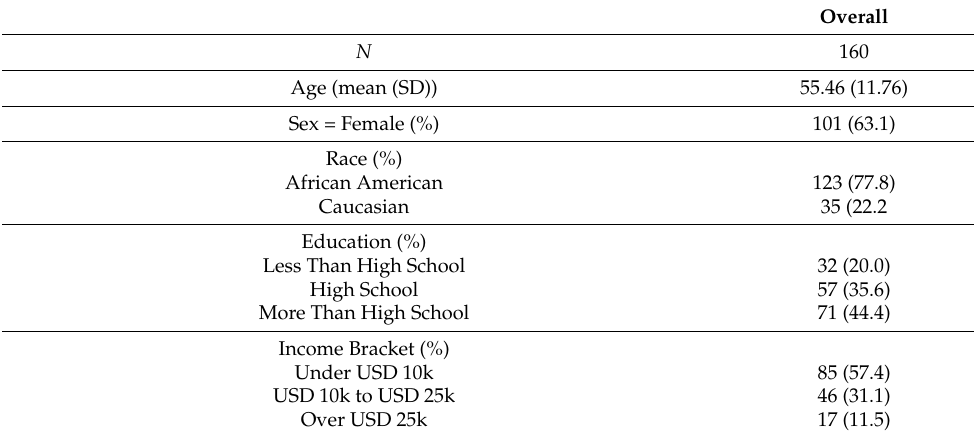
Figure 1. Jittered home locations of respondents (colored by perceived food access) and objective food access (illustrated by kernel density estimation of store scores). Table 1. Summary statistics.